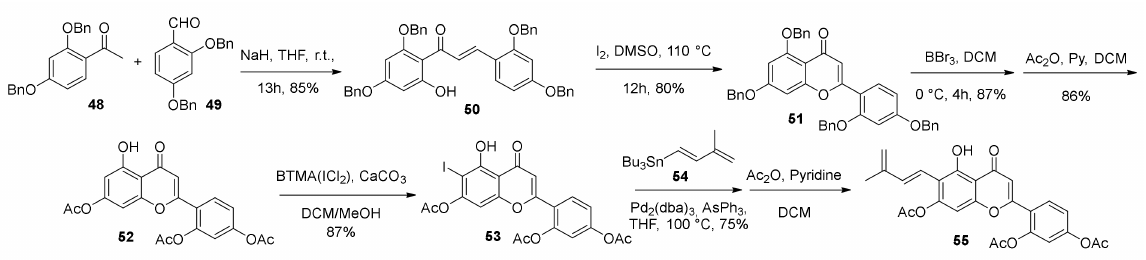
Figure 15. Retrosynthetic analysis of artonin I ( 34 ) by chemoenzymatic synthesis.